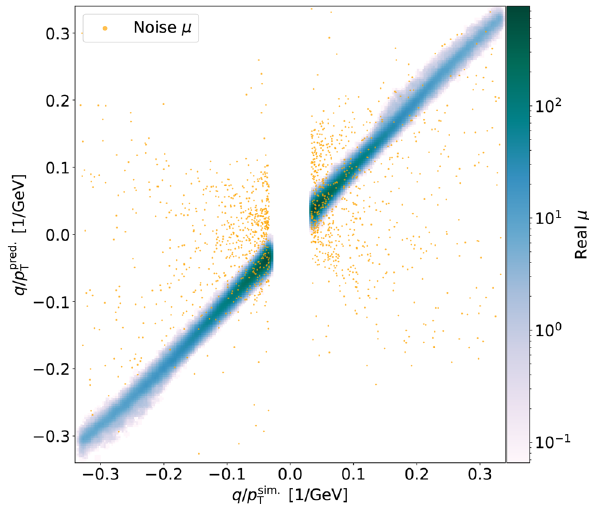
Fig. 6 Output of the neural network plotted as a function of the true simulated muon q / p T using network trained with events including only muon hits. Colour coded density map shows muon candidates without any noise hits. Orange dots show muon candidates that include at least one noise cluster